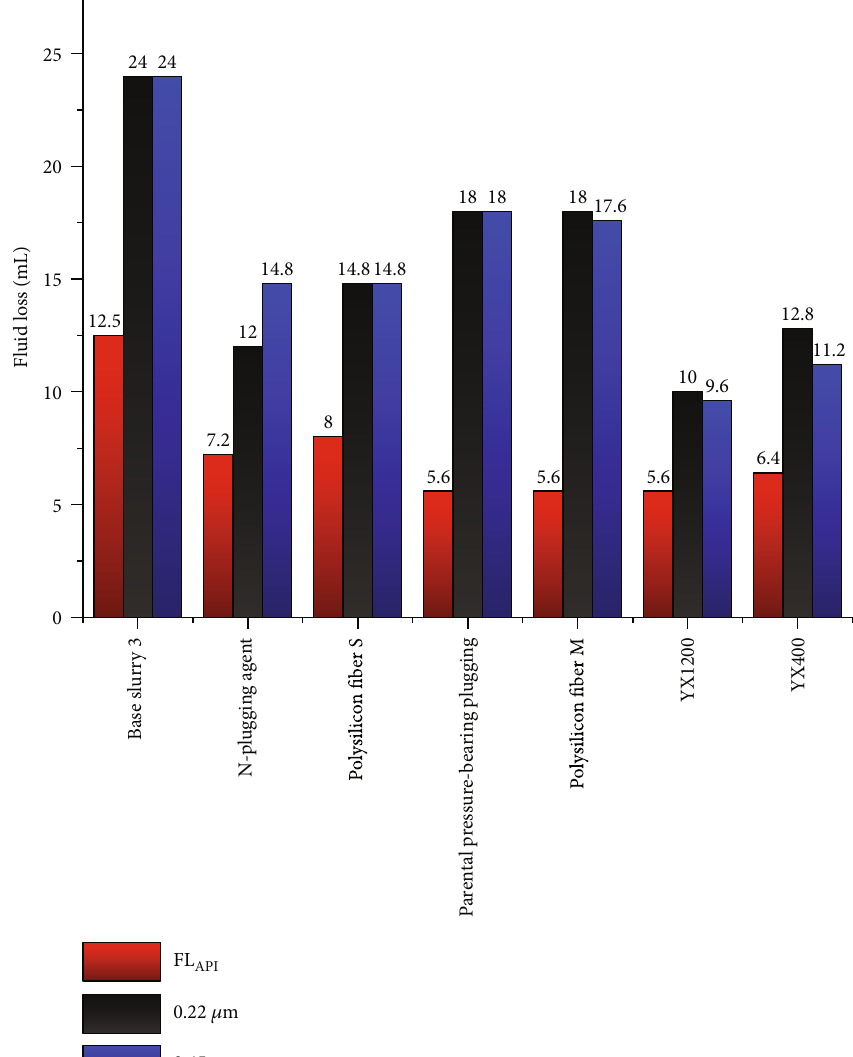
Figure 4: Experimental results of plugging agent optimization.